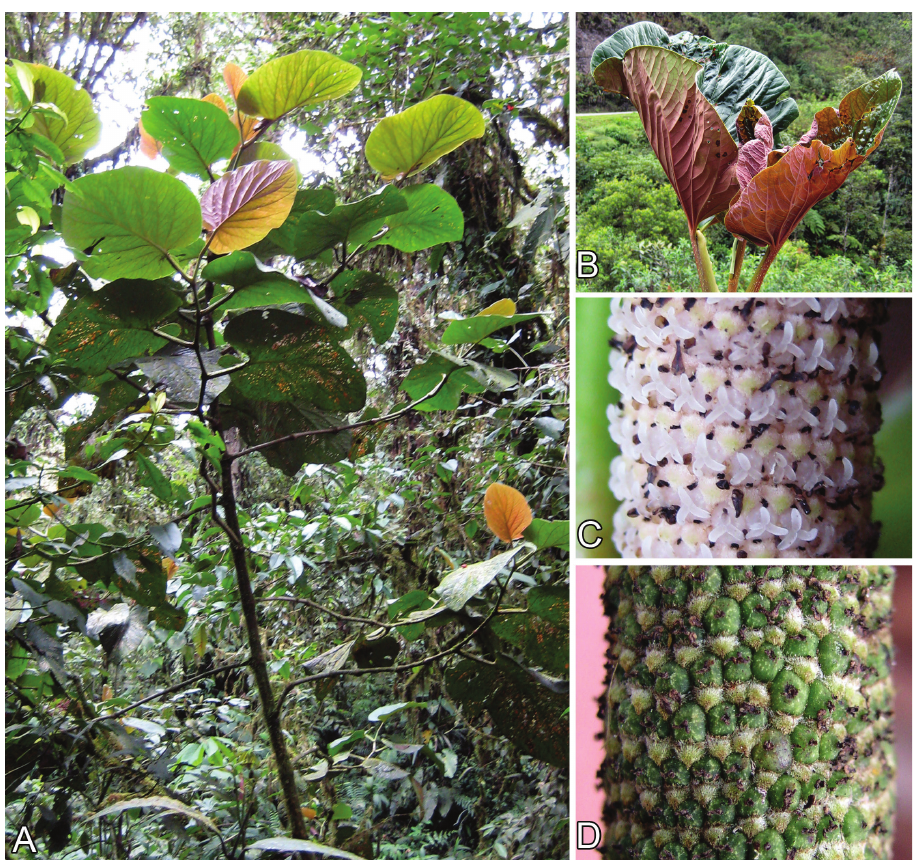
Figure 2. Piper kelleyi . A Habit B Close-up of leaves showing characteristic red color of younger leaves [Tepe et al. 2381] C Close-up of inflorescence [Tepe et al. 2615] D Close-up of infructescence [Tepe et al.